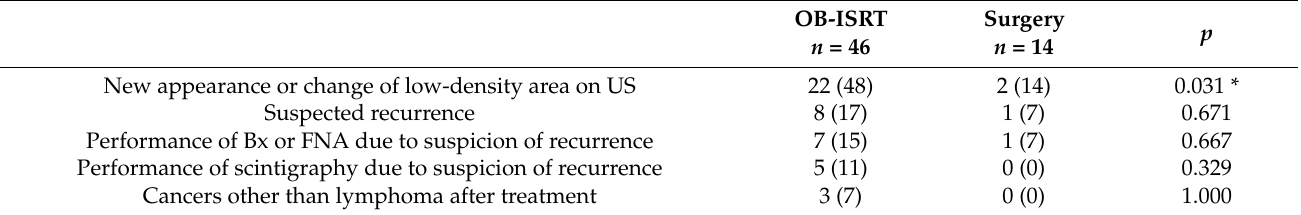
Table 3. Comparison of the post-treatment course between the OB-ISRT and Surgery groups.